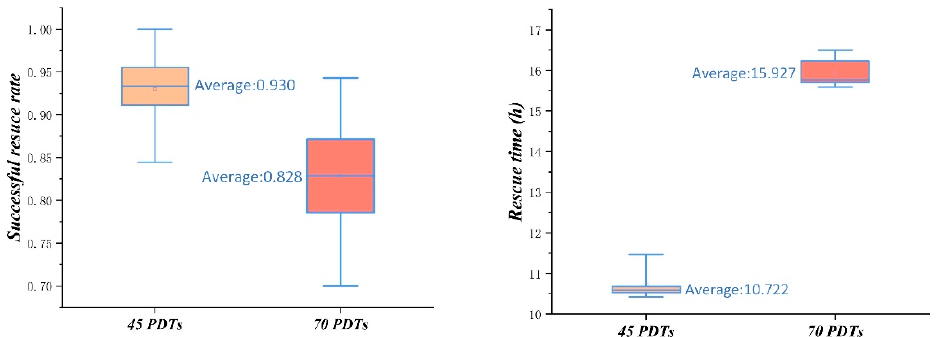
Figure 14. The box line diagram of the successful rescue rate and the rescue time for the TPM-0.5.